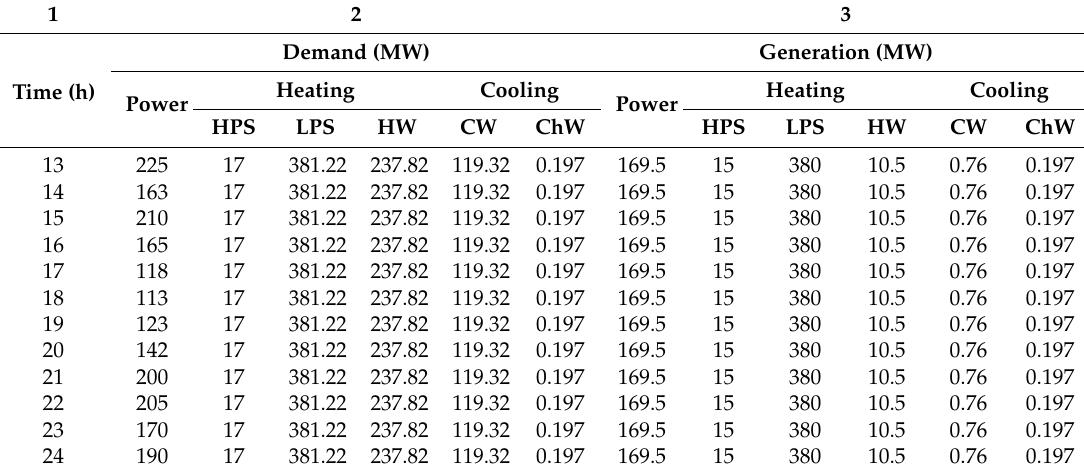
Table A2. TriGenSCA before iteration from time 13 to 24